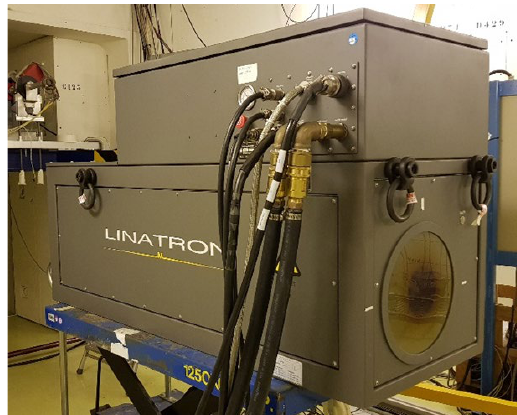
Fig. 1. The Linatron-M9 linac housed at the SAPHIR platform (CEA Saclay,